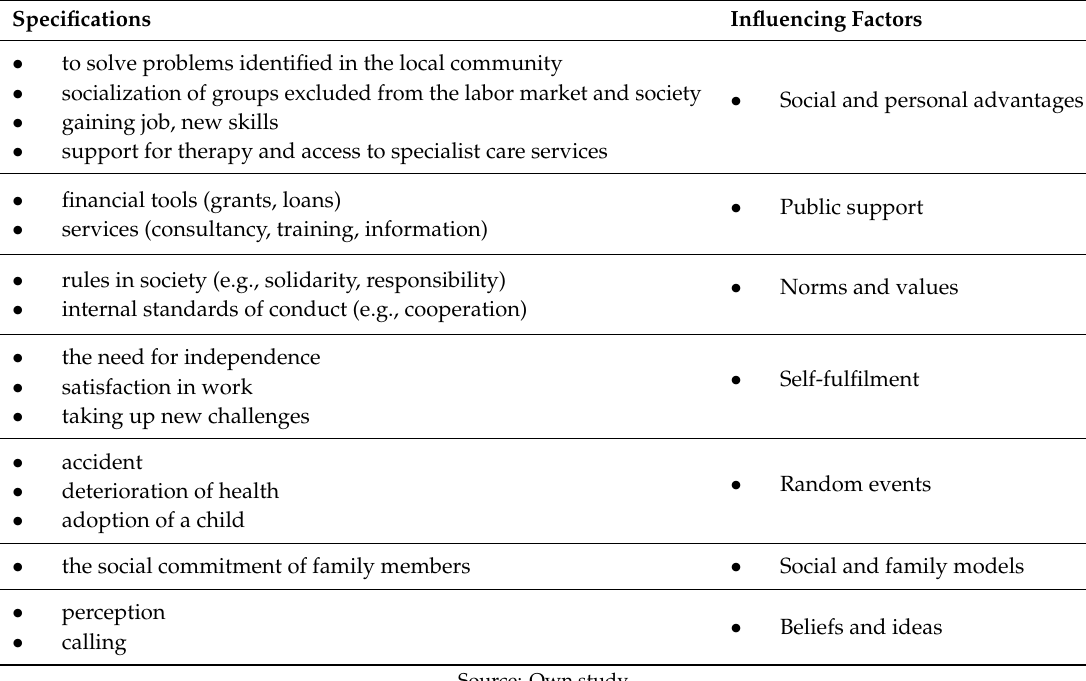
Table 3. Influencing factors of the involvement in social